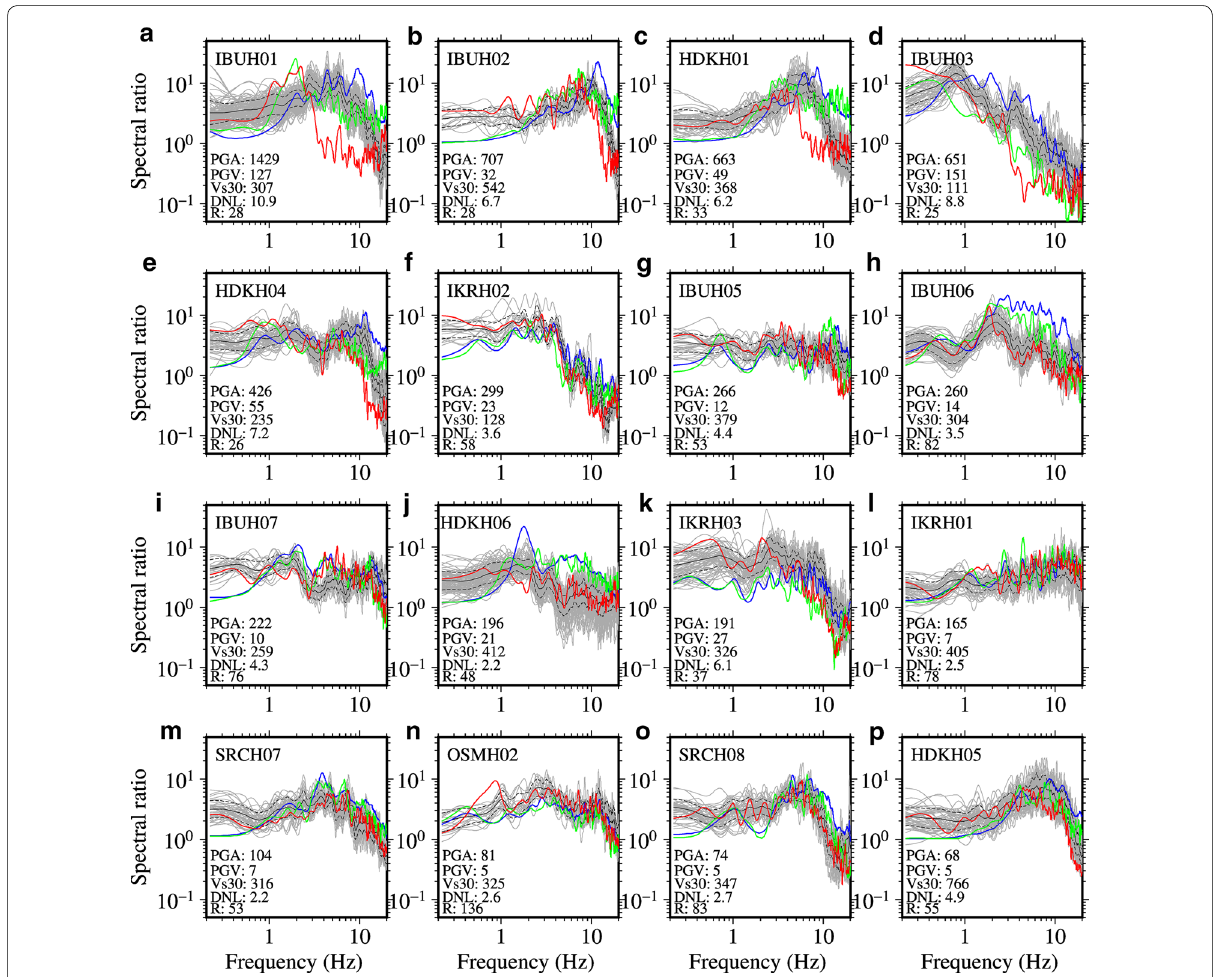
Fig. 12 Plots of H-to-V spectral ratios of surface recordings during weak-motions (gray lines) and those during the mainshock (red lines) at KiK-net sites. The green and blue lines denote the S-to-B spectral ratios of horizontal components (H-to-H) for mainshock and weak-motions, respectively (see also Fig. 5). The plots are arranged in order of the sites depicted in Figs. 5 and 7. Solid black lines denote mean spectral ratios for weak-motions and dashed gray lines denote one standard deviation. The horizontal vector PGA in units of cm/s 2 , horizontal vector PGV in units of cm/s, Vs30 in units of m/s, DNL values, and fault-to-site distance ( R ) in units of km are also included for each site. See Fig. 3 for site